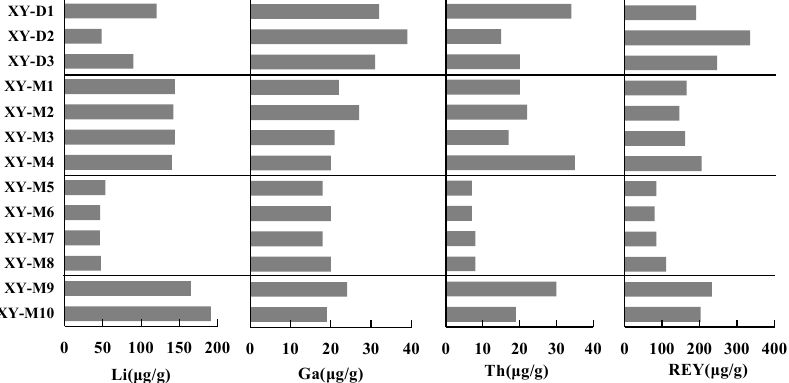
Figure 3. Vertical distribution of Li, Ga, Th and REY in the No. 9 coal and related roof samples from the Xinyuan mine.